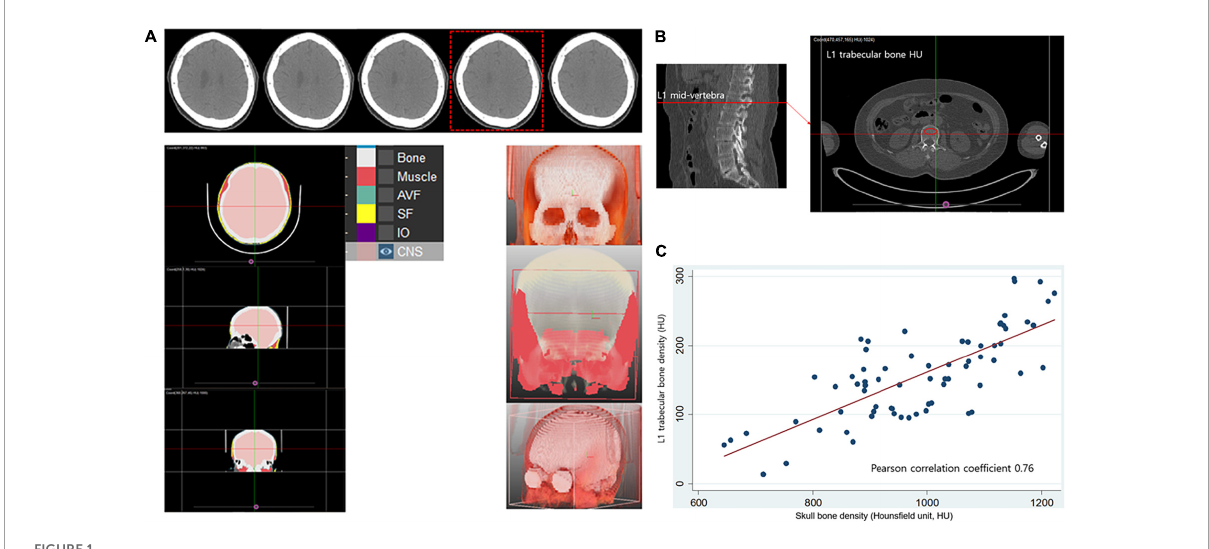
FIGURE1 Measurement of Hounsfield unit in skull and lumbar bone and their correlation in healthy control. (A) Segmentation of skull bone and calculation of radiation attenuation value of skull bone area using automated deep learning software (DeepCatch, Medical IP, Korea). Skull bone HU values were measured using single slice CT image at the predefined level where the lateral ventricles immediately disappear. (B) Measurement of lumbar spine trabecular bone radiation attenuation. (C) Significant positive correlation ( r = 0.76, p < 0.001) between skull bone density and lumbar spine trabecular bone density measured from computed tomography scans. HU, Hounsfield